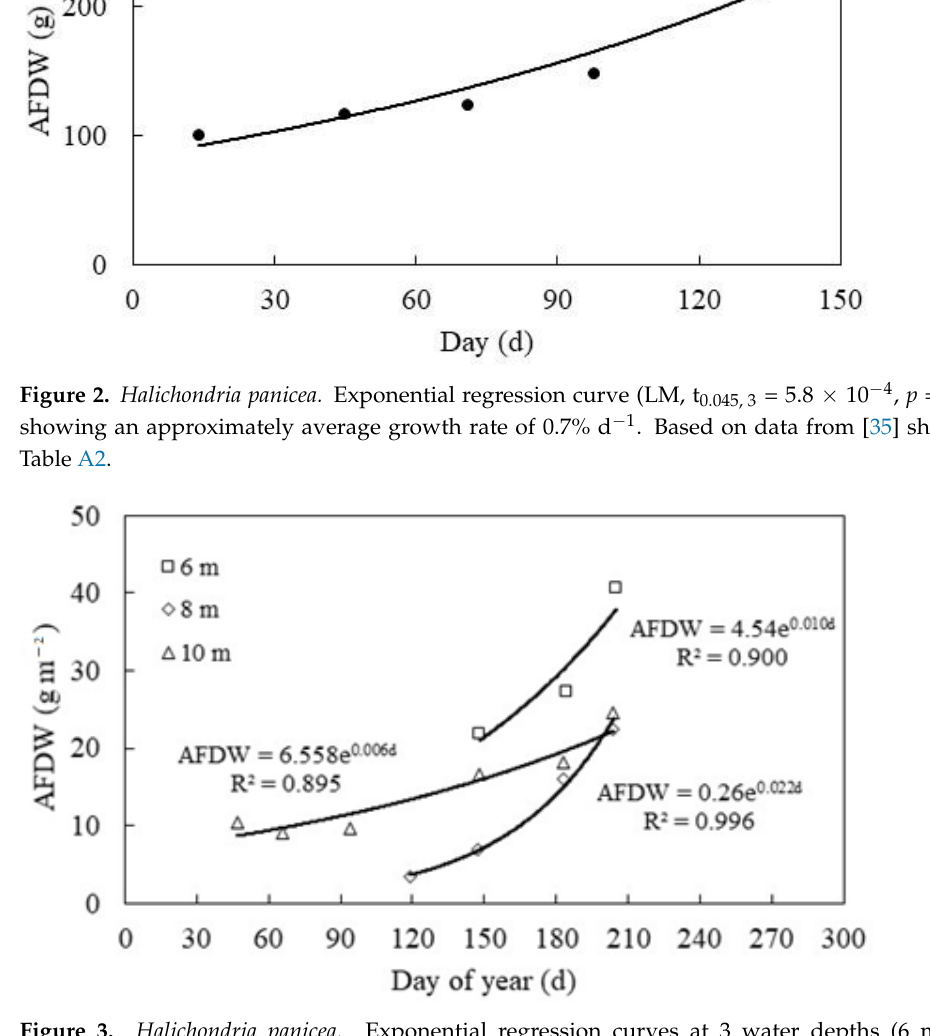
Figure 3. Halichondria panicea. Exponential regression curves at 3 water depths (6 m: LM, t 0.006, 1 = 1.5 × 10 − 3 , p = 0.205; 8 m: LM, t 0.030, 2 = 4.6 × 10 − 4 , p = 0.002; 10 m: LM, t 0.064, 4 = 4.5 × 10 − 4 , p = 0.004) showing approximate average growth rates of µ avg = 1.0, 2.2 and 0.6% d − 1 . Based on data from [36] shown in Table